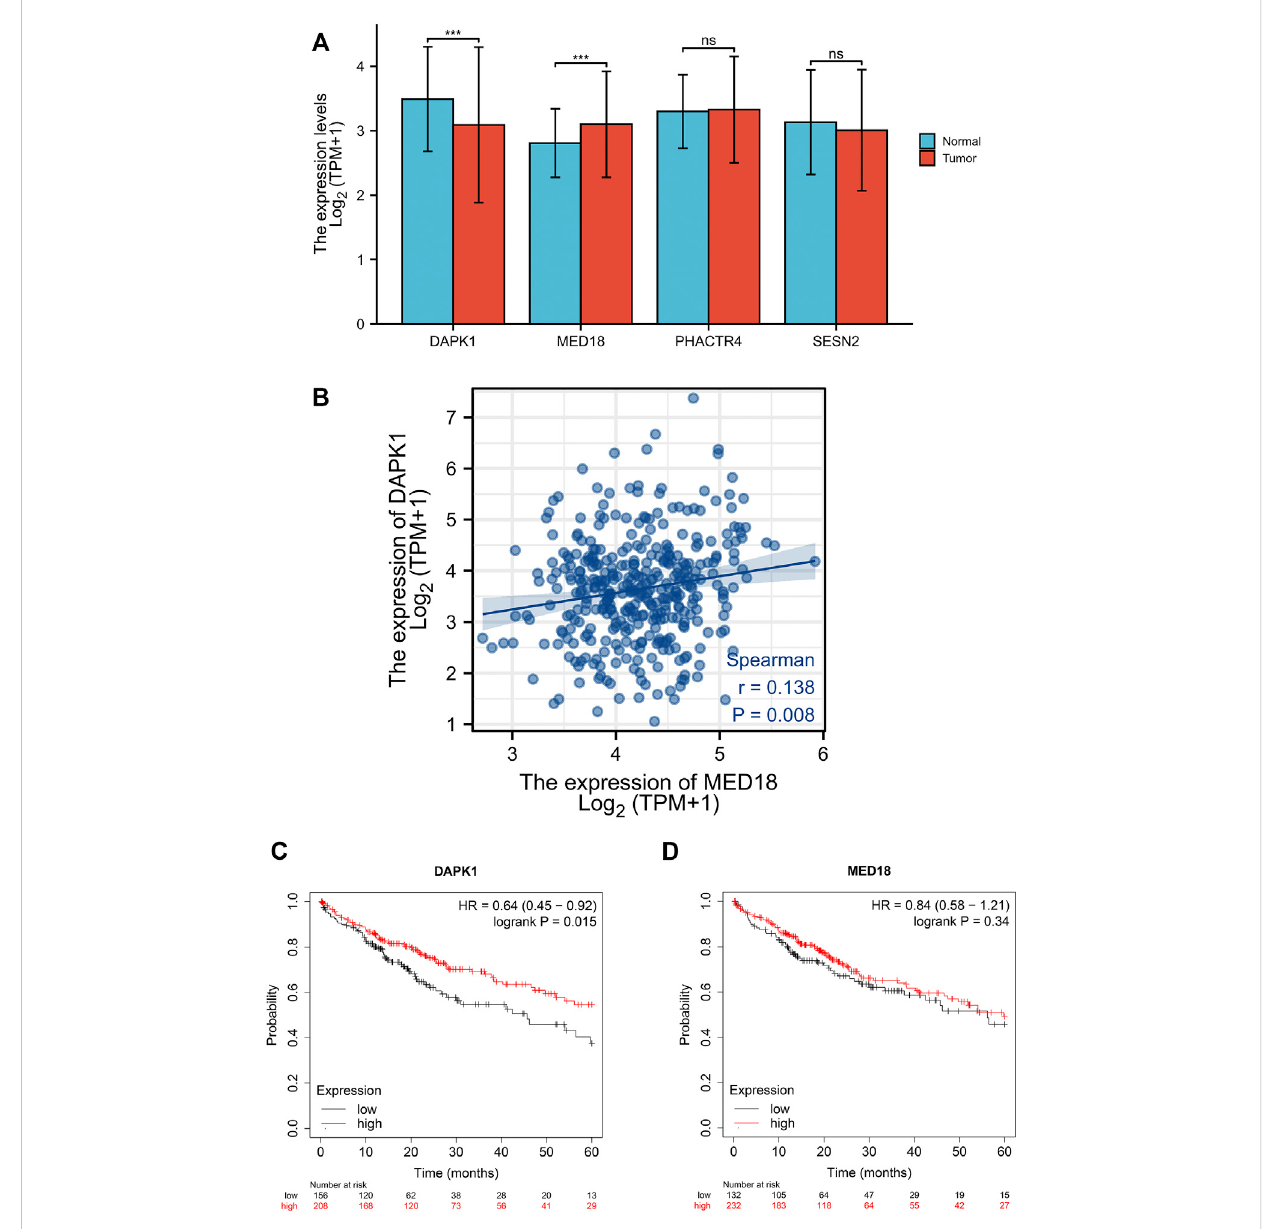
FIGURE 2 Identi fi cationofco-regulatorydifferentiallyexpressedprognosis-related genes. (A) Theexpressionlevelofco-regulatorygenesbetweenTCGAand GTEx cohort. (B) The expression association between DAPK1 and MED18. (C) Kaplan-Meier analysis of DAPK1 expression levels and overall survival. (D) Kaplan-Meier analysis of MED18 expression levels and overall survival (* p < 0.05, ** p < 0.01, *** p <